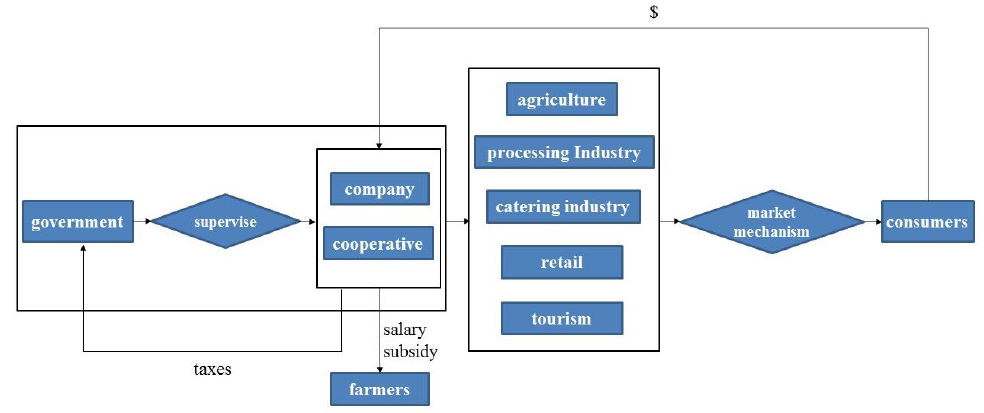
Figure 3. Flowchart of Chehe Village operation mode. Note: the flowchart was drew by author according to survey and interview.